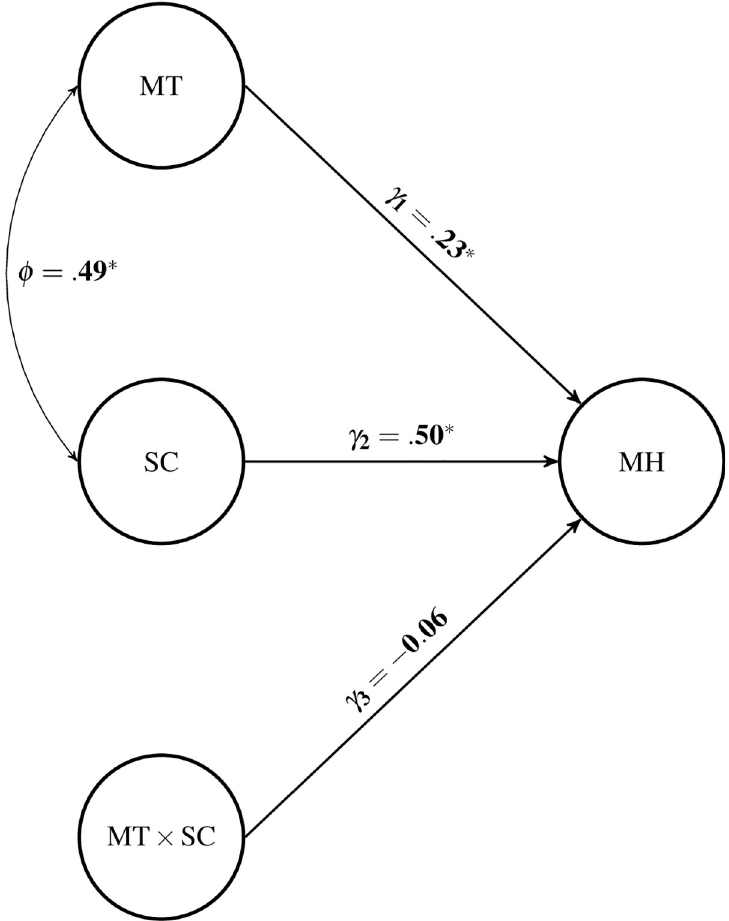
Fig 2. Structural parameter estimates from moderation